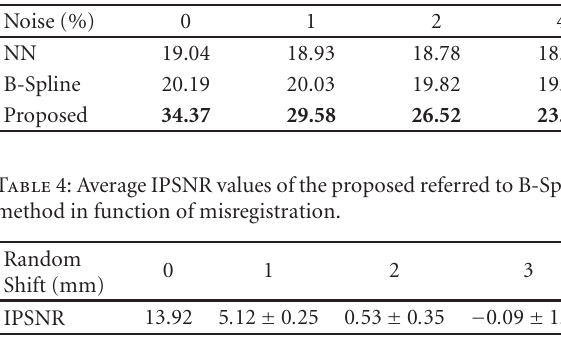
Table 3: PSNR values of the di ff erent methods compared for several noise levels.